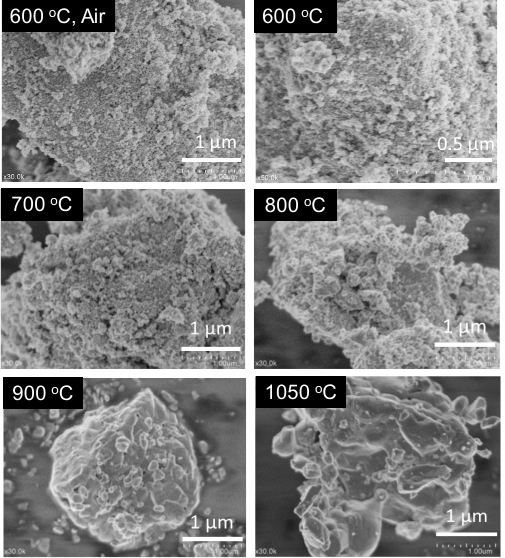
Figure 2. SEM images of the titanium-niobium oxides prepared at 600 °C in air, and 600, 700, 800, 900, and 1050 °C in Ar containing 4% H 2 .